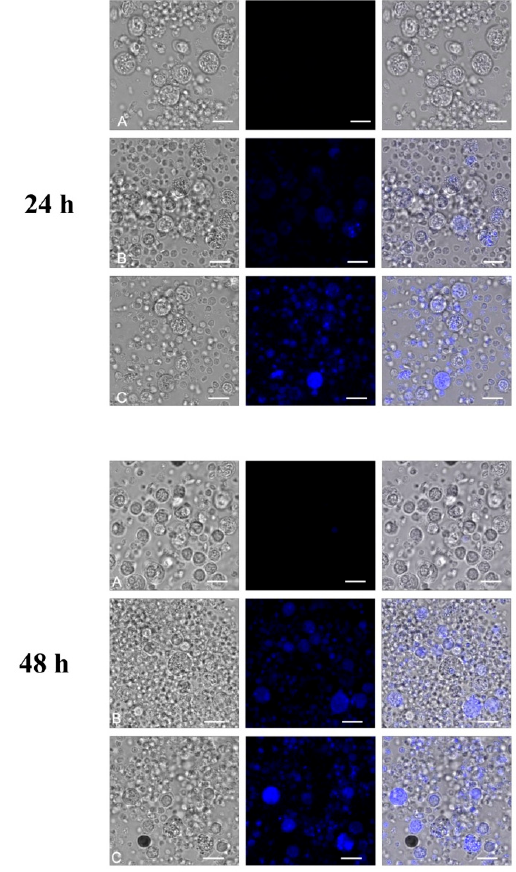
Figure 4. Confocal microscopy images of peripheral blood mononuclear cells (PBMCs) after 24 h and 48 h of incubation with fullerenol (37 °C, 5% CO 2 atmosphere, 100% relative humidity). To analyze nanoparticle internalization, the following excitation and emission wavelengths were used: 405 nm for excitation and the range of 420–530 nm for emission. A, Control (without fullerenol); B, 75 mg/L; C, 150 mg/L. Bar = 10 μ m.